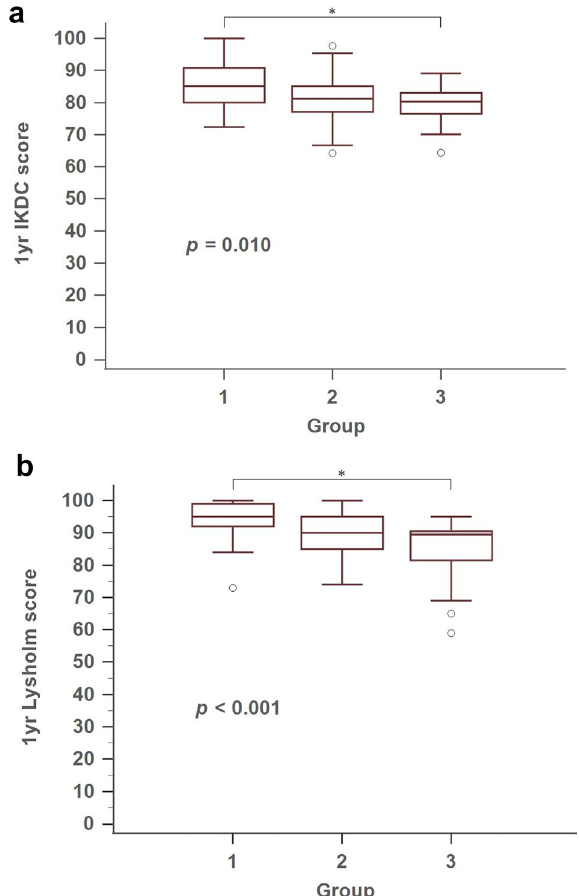
Figure 2. Comparison of subjesctive knee functional score at 1 year, between groups. ( a ) IKDC score, IKDC, International Knee Documentation Committee; ( b ) Lysholm score. Asterisks indicate statistically significant differences between the two measurements by post hoc Dunn test ( p < 0.05).